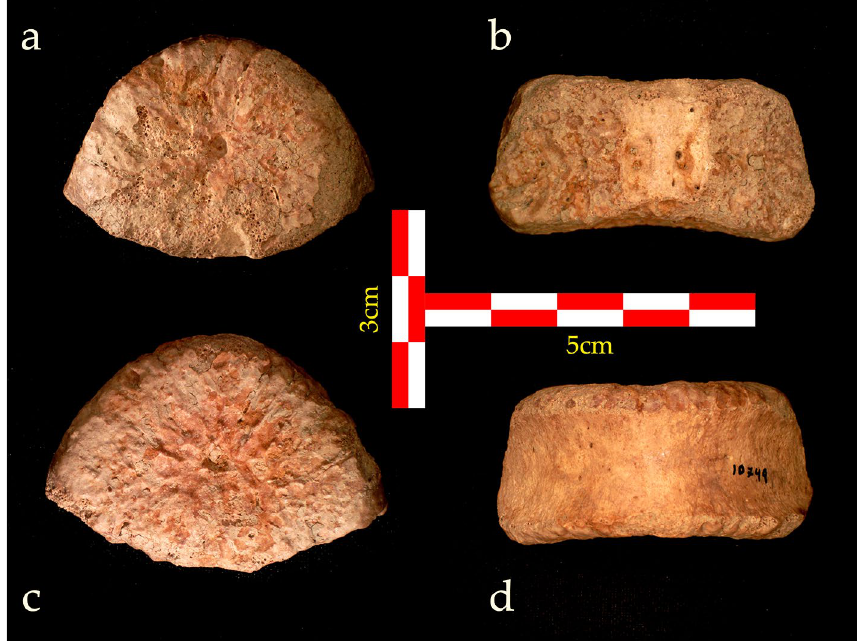
Figure 2. UB 10749 vertebral body. ( a ) Superior view; ( b ) posterior view; ( c ) inferior view; ( d ) anterior view.